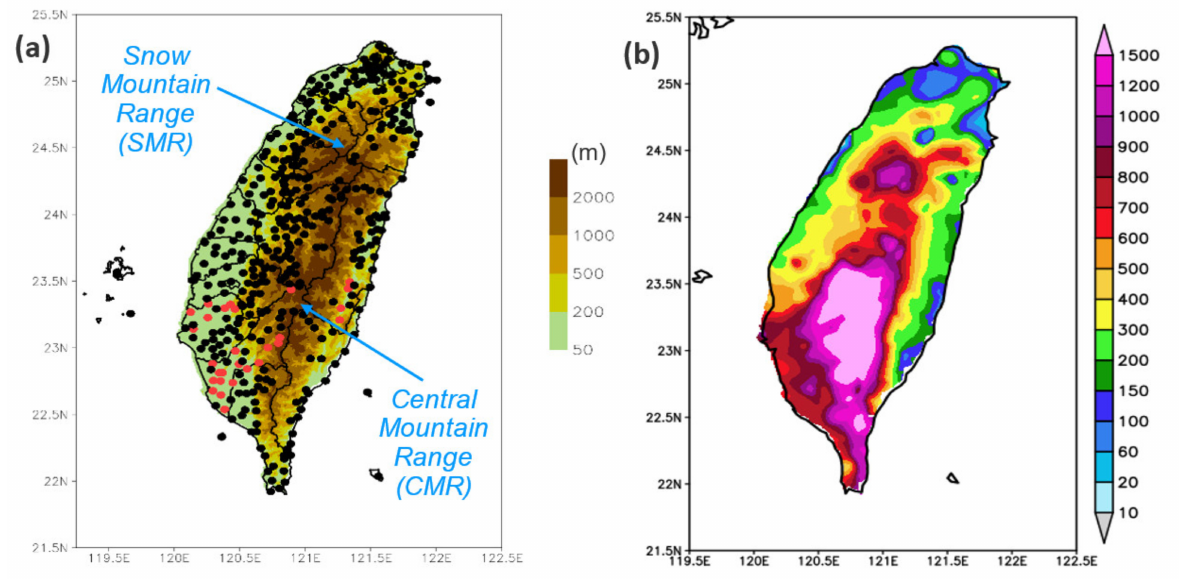
Figure 1. ( a ) The topography of Taiwan (m, color) and distribution of rain gauges (dots), and ( b ) distribution of 3-day total rainfall over 7–9 August (in UTC) from TY Morakot (2009), with a peak amount of 2748 mm. In ( a ), the Central Mountain Range (CMR) and Snow Mountain Range (SMR) of Taiwan are indicated, and red dots depict gauge stations damaged by